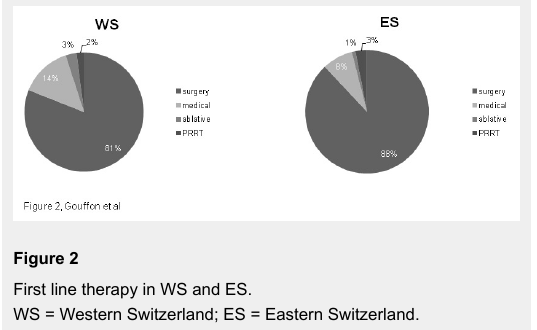
Table 1: Repartition of functional NENs according to type and geographical region. Name / Type Carcinoid syndrome